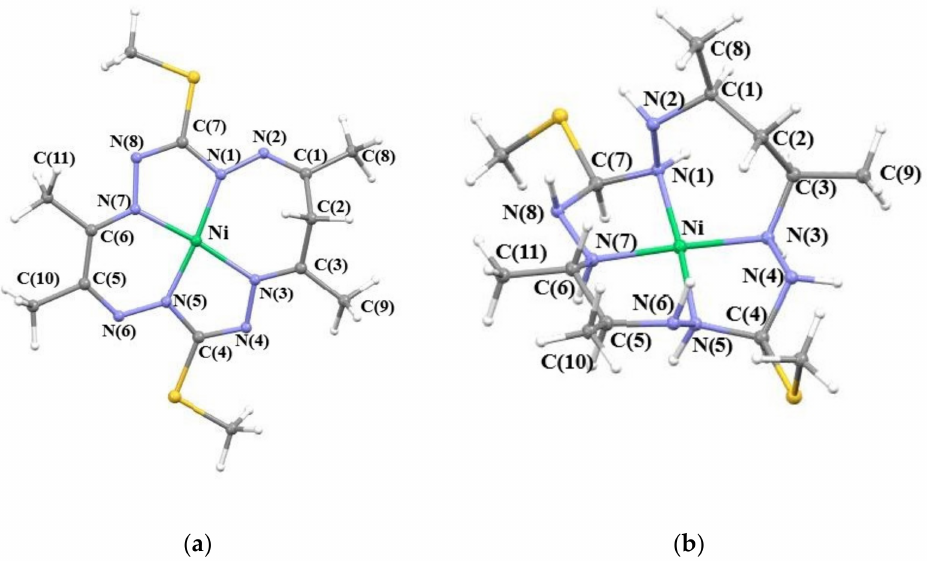
Figure 1. Optimized molecular structures of ( a ) 1 [ NiL ] 0 and ( b ) 1 [ NiLH ] 2+ complexes with atom